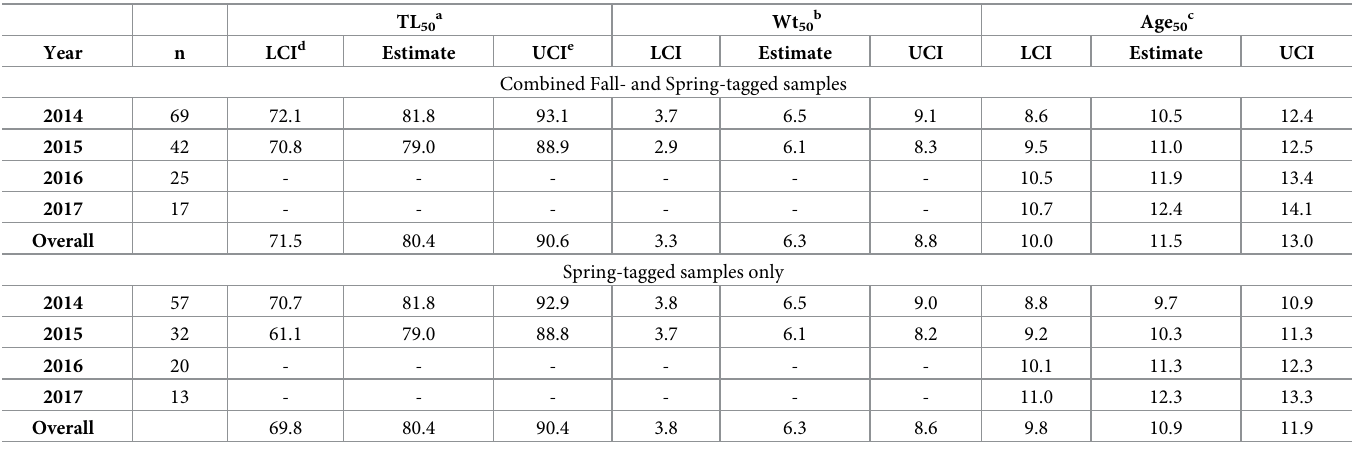
Table 1. Estimates of 50th percentile shelf migrant incidence for length, weight and age.